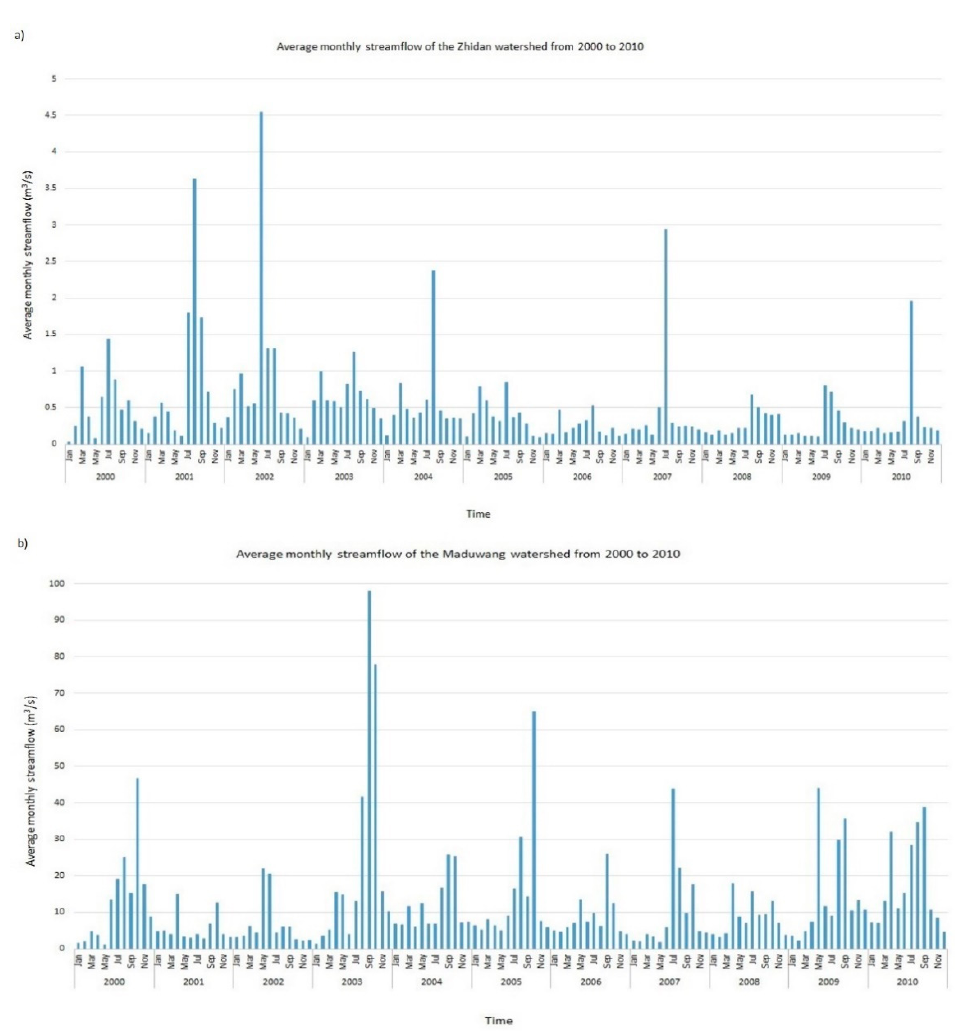
Figure 4. Plot of the average monthly streamflow of the ( a ) Zhidan and ( b ) complete Maduwang datasets.